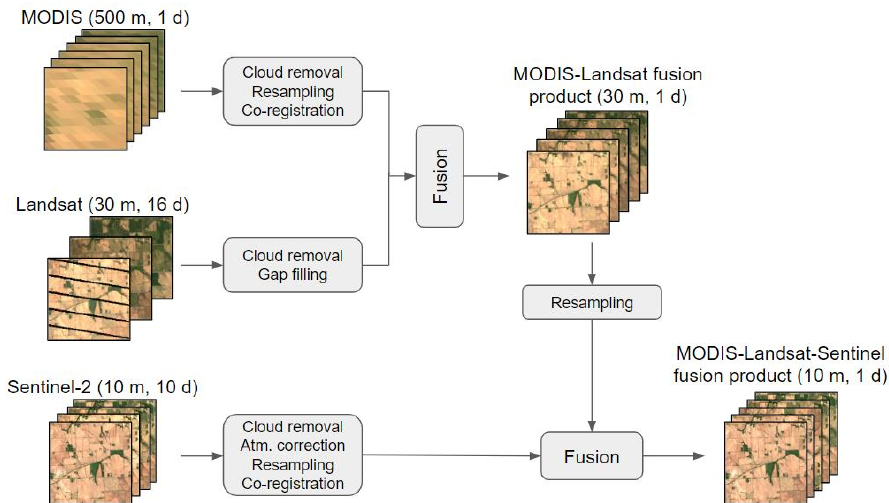
Figure 1. Schematic overview of the fusion method of STAIR 2.0. STAIR 2.0 is a generic framework that can fuse multiple sources of optical satellite data and produce a high-resolution, daily and cloud-/gap-free surface reflectance product. The input of STAIR 2.0 is multiple sources of optical satellite data with different spatial and temporal resolutions, i.e., MODIS (500 m, 1 day), Landsat (30 m, 16 days), and Sentinel-2 (10–20 m, 10 days). STAIR 2.0 pre-processes the input data, imputes missing-value pixels (due to cloud and sensor damages), and uses a stepwise strategy—from coarse resolution to fine resolution—to produce a high spatial- (10 m) and temporal-resolution (daily)